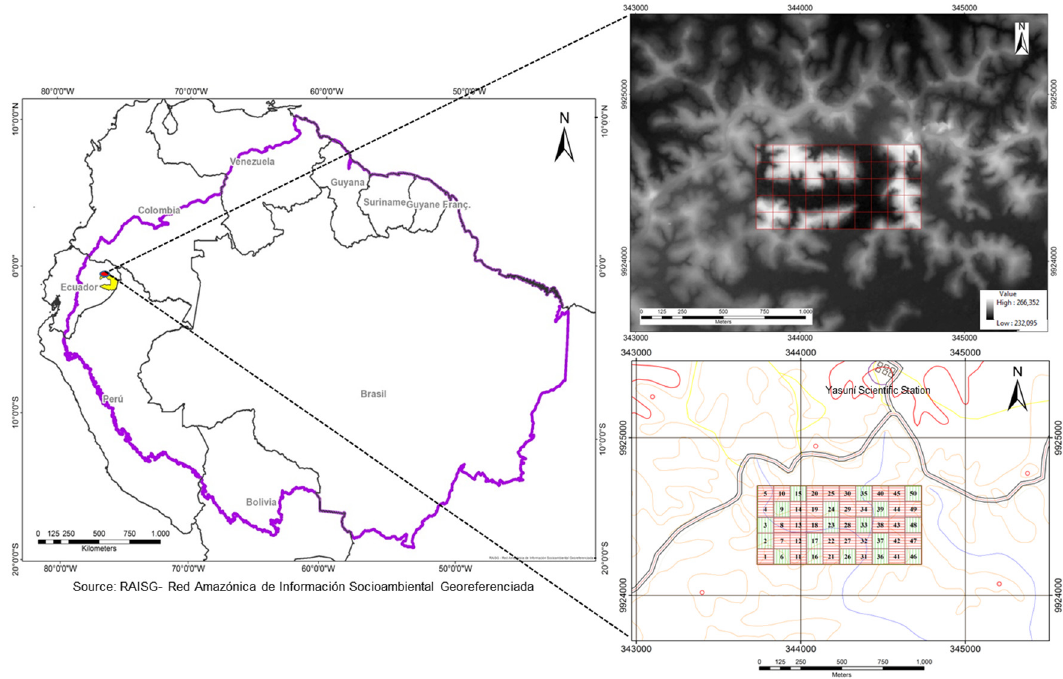
Figure 1. ( Left ) Location of the study area (red point) within the Yasuní National Park (in yellow) in the western Amazonian Basin. ( Upper right ) Digital Terrain Model of the 50-ha forest plot (centered rectangle). ( Lower right ) A regular grid system of 1-ha subplots used for calibration (red) and validation (green) of the airborne LiDAR model for aboveground carbon density estimation.